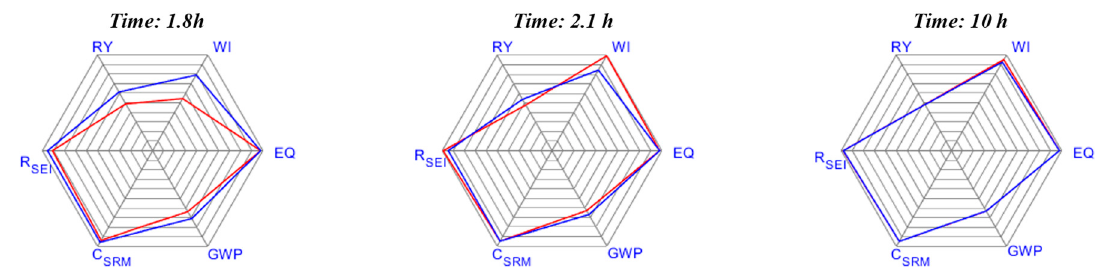
Figure 10. Case 1—comparison between control without Water Intensity (WI) constraint (red line) and control with WI constraint (blue line) at three representative sample points.